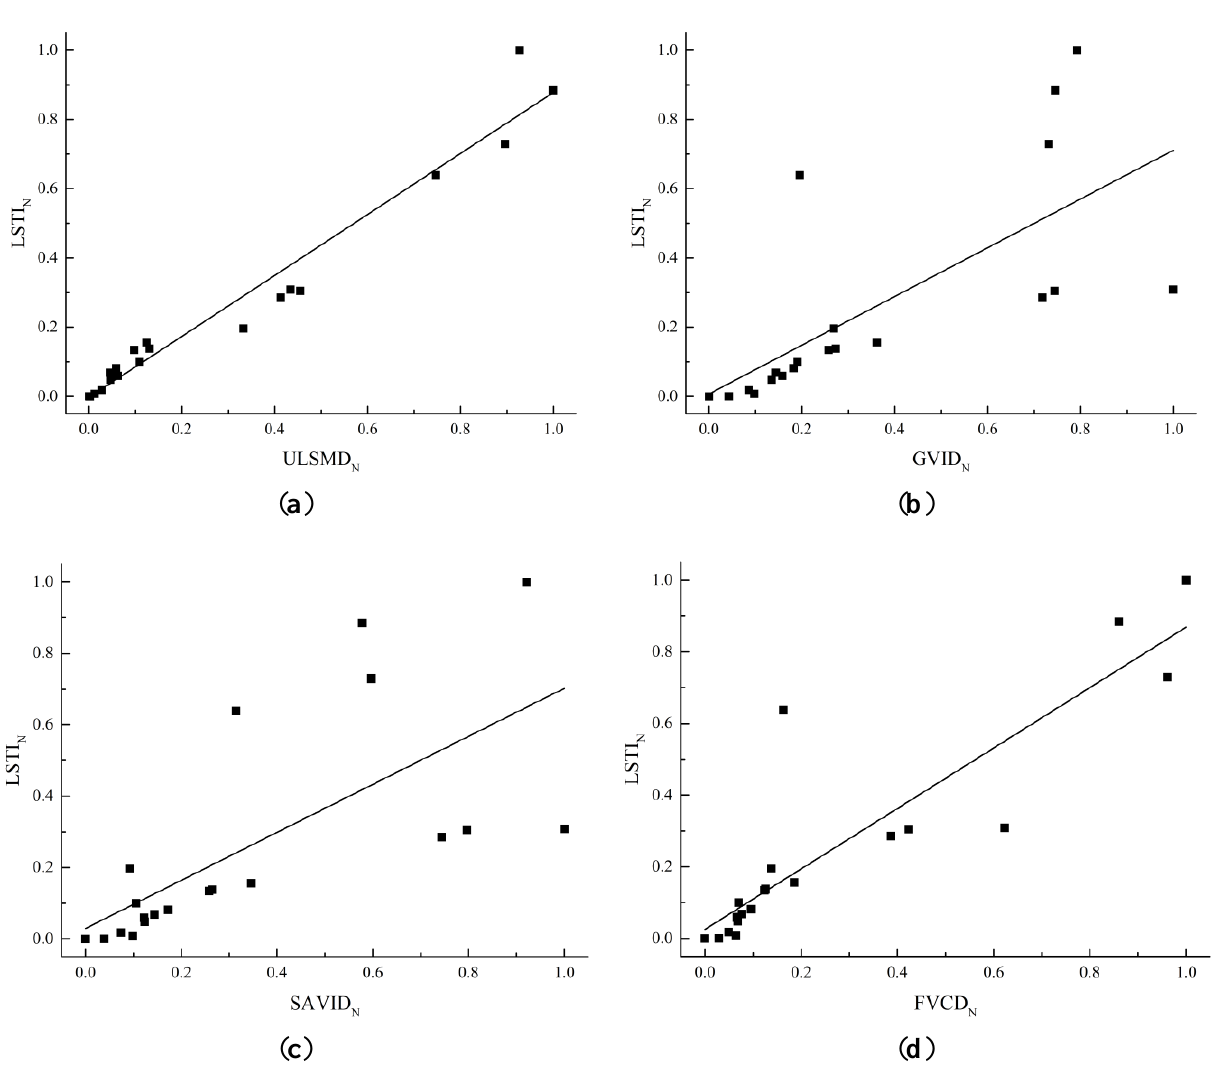
Figure 10. ( a ) Linear regression between LSTI N and ULSMD N ; ( b ) Linear regression between LSTI N and GVID N ; ( c ) Linear regression between LSTI N and SAVID N ; ( d ) Linear regression between LSTI N and FVCD N